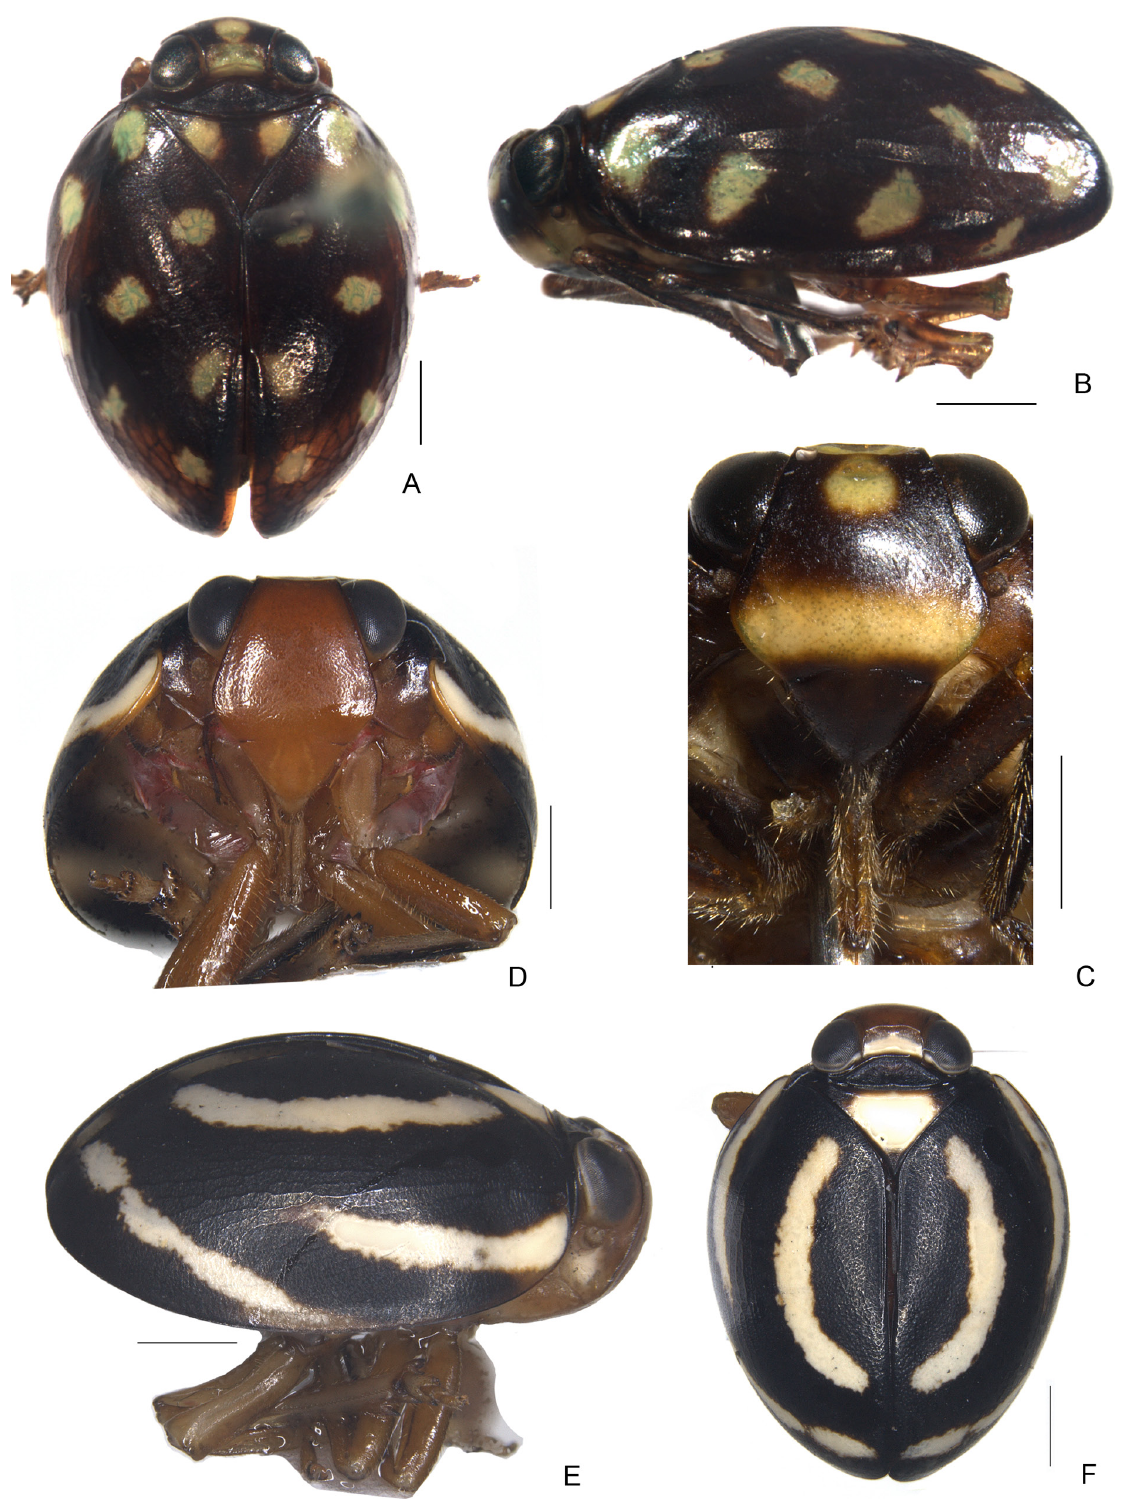
Fig. 9. Gnezdilovius spp. A–C . Gnezdilovius multipunctatus (Che, Zhang & Wang, 2007) comb. nov., paratype. A . Habitus, dorsal view. B . Habitus, lateral view. C . Metope and clypeus, facial view. — D–F . Gnezdilovius lineatus (Kato, 1933) comb. nov. D . Metope and clypeus, facial view. E . Habitus, lateral view. F . Habitus, dorsal view. Scale bars = 1